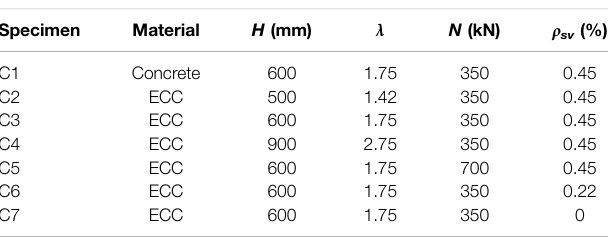
TABLE 2 | Test matrix of the columns. Specimen